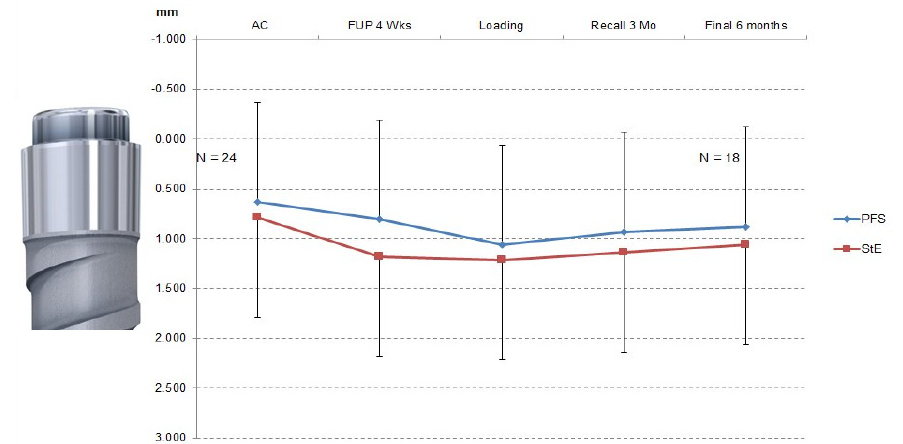
Figure 2. Bone level changes (error bars: PFS mean + standard deviation; StE mean: standard deviation). The first bone-to-implant contact was observed approximately 1